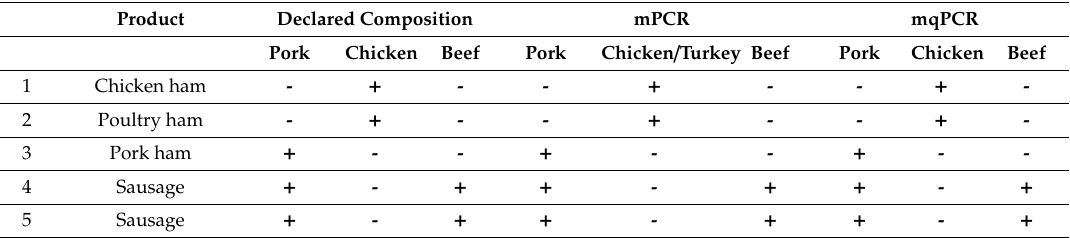
Table 4. Results of meat sample by DNA